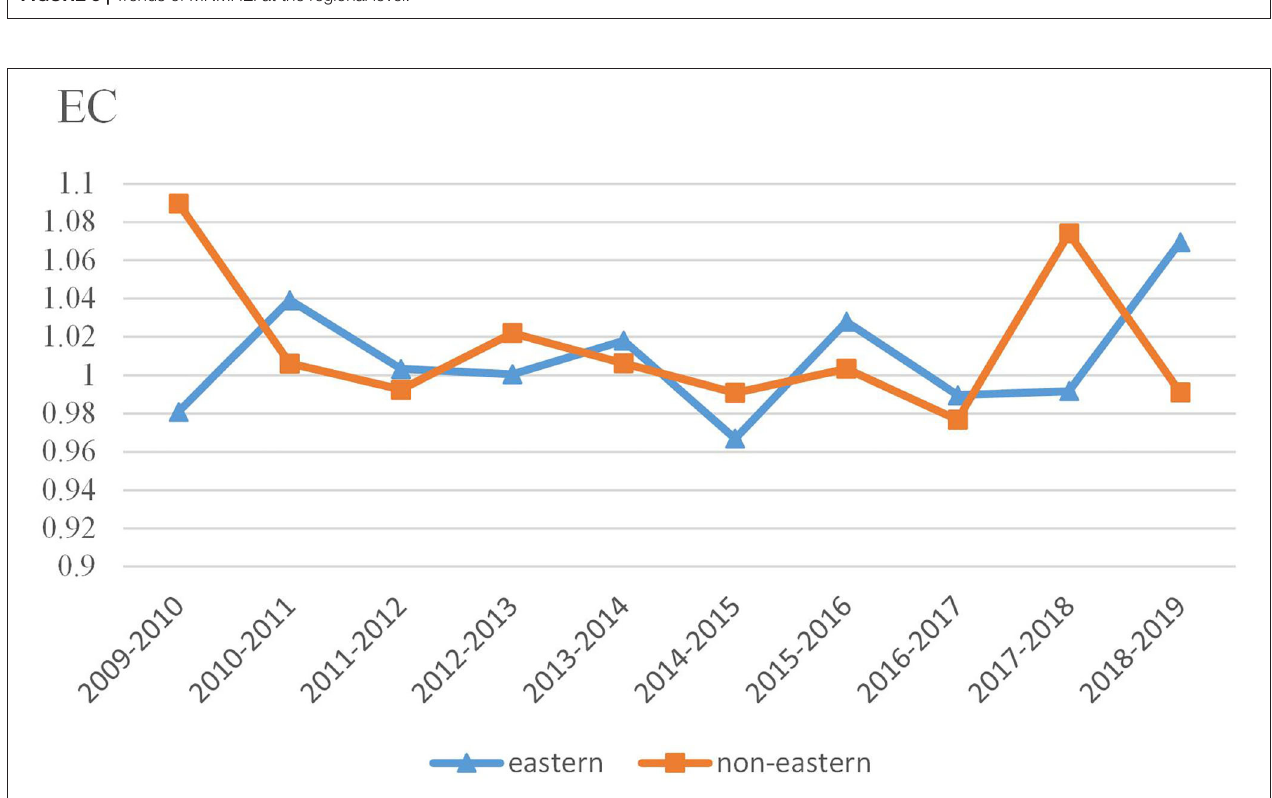
FIGURE 4 | Trends of EC at the regional